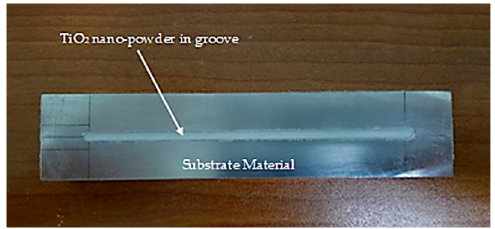
Figure 2. TiO 2 inserted in the groove on the substrate material.